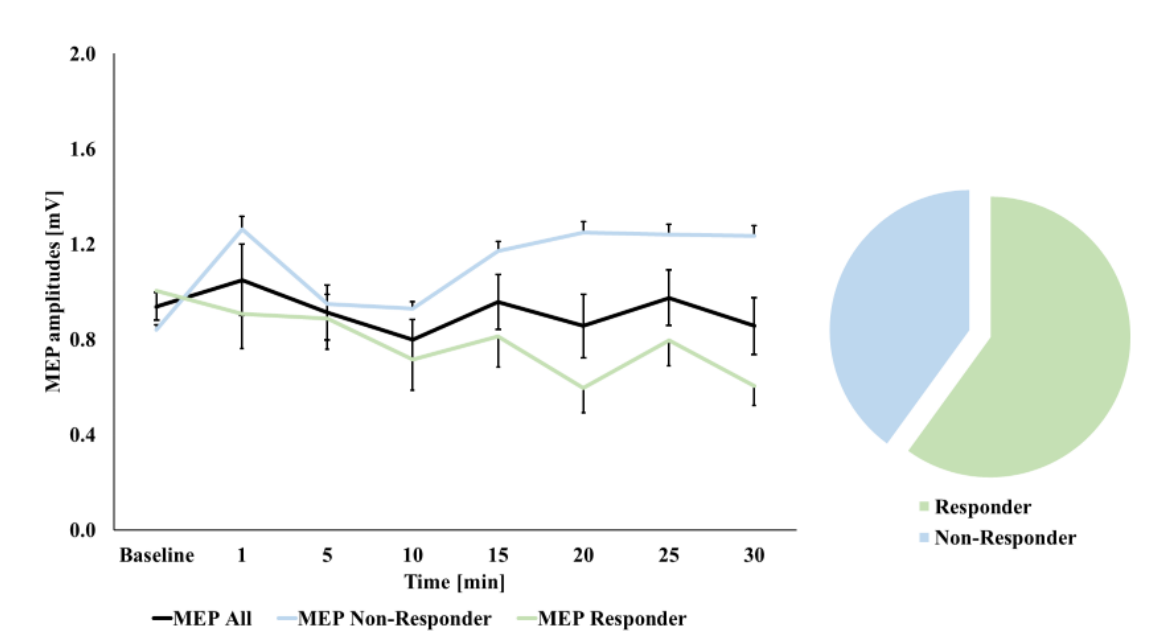
Figure 3. Motor-evoked potential (MEP) curves at baseline and following cTBS 600 stimulation. Time bins are reported in minutes. Black curve: MEP curve of all subjects; green curve: MEP curve of participants showing expected after effects (MEP magnitude decrease; shown for a <100% threshold here); blue curve: MEP curve of participants showing unexpected after-effects. Error bars refer to standard error (SEM).